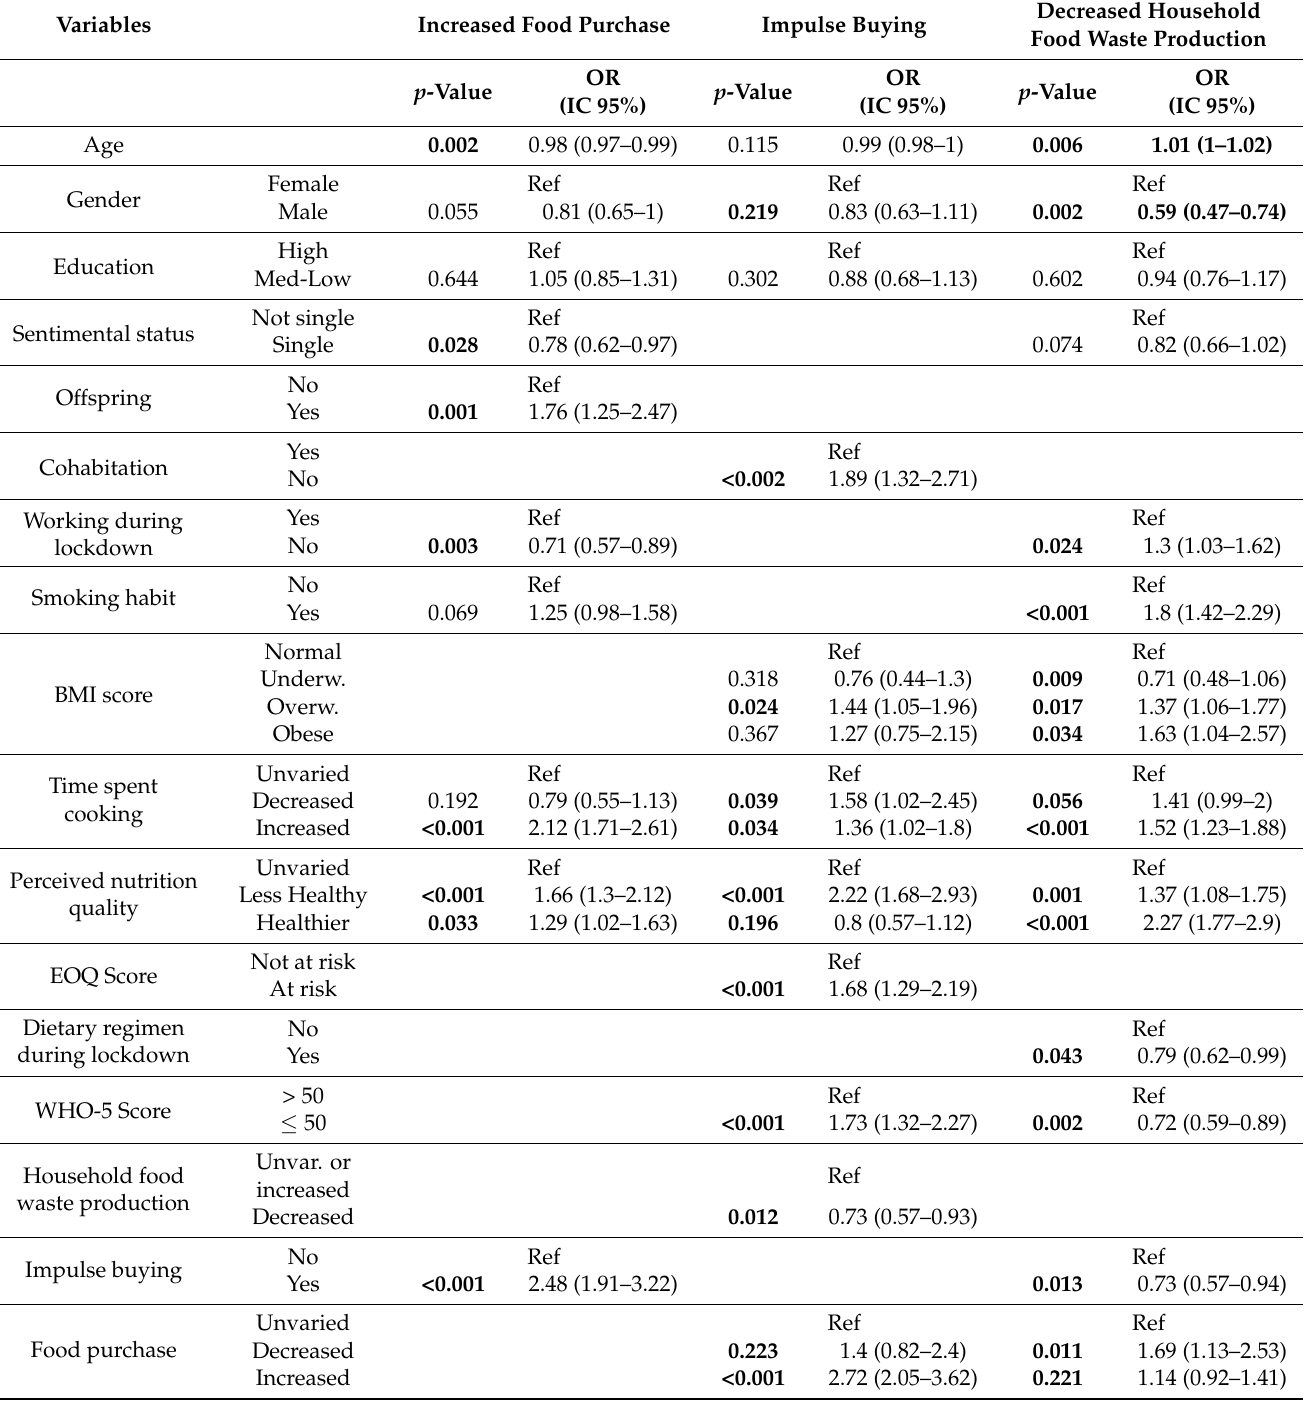
Table 3. Multivariable analysis: determinants of self-perceived changes of food purchase, household food waste production and occurrence of impulse